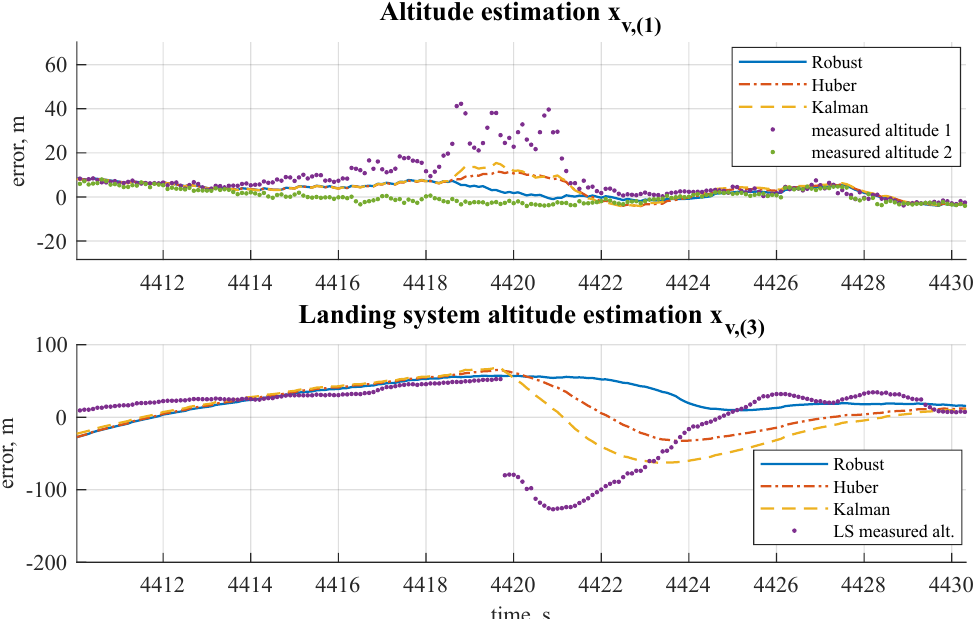
Figure 12. Filters response to abnormal vertical channel errors. «Robust»—the proposed robust algorithm. «Huber»—M